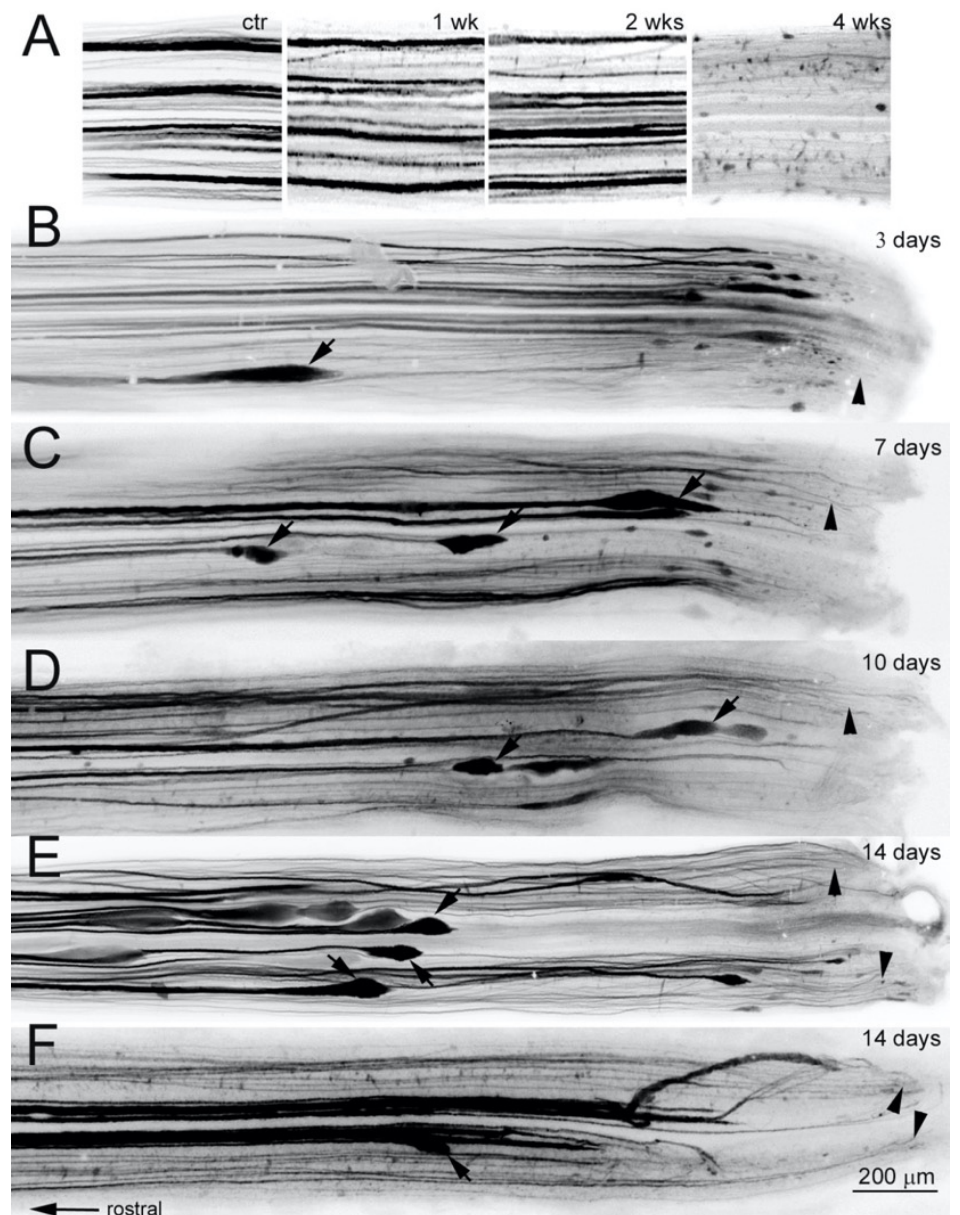
Figure 8. Small caliber axons retracted less than giant axons. ( A ) Wallerian degeneration is slow in the lamprey. ( A ) (ctr), at 3 days post-TX at the 5th gill, retrogradely labeled RS axons a few mm rostral to the TX show no degeneration, and serve as a control. ( A ) (1–4 wks), the SC beginning 5 mm caudal to the TX site at 1, 2 and 4 weeks post-TX, showing anterogradely labeled axons. At 1 and 2 weeks, there were no signs of Wallerian degeneration, whereas by 4 weeks, most giant RS axons had degenerated. Thus, after TX of the SC to introduce a fluorescent label into axons, and allowing up to 1 week for anterograde transport of the dye does not cause distortion of axon structure due to Wallerian degeneration. ( B – F ) Axons were anterogradely labeled from a 2nd SC TX near the spinal– medullary junction (~5 mm rostral to original TX) at 3 ( B ), 7 ( C ), 10 ( D ), and 14 ( E , F ) days after an initial TX at the 5th gill. Spinal cords were removed, fixed, cleared in BABB, and photographed by wildfield microscopy after allowing 3 days for transport of the dye. The giant RS axons located ventromedially retracted rostrally and developed large bulbous ends (arrows), while small axons remained near the TX site (arrowheads) at all times examined, indicating that small axons retract much less than the large-caliber axons. The TX site is on the right, and rostral is left. Calibration bar = 200 µm for all frames.